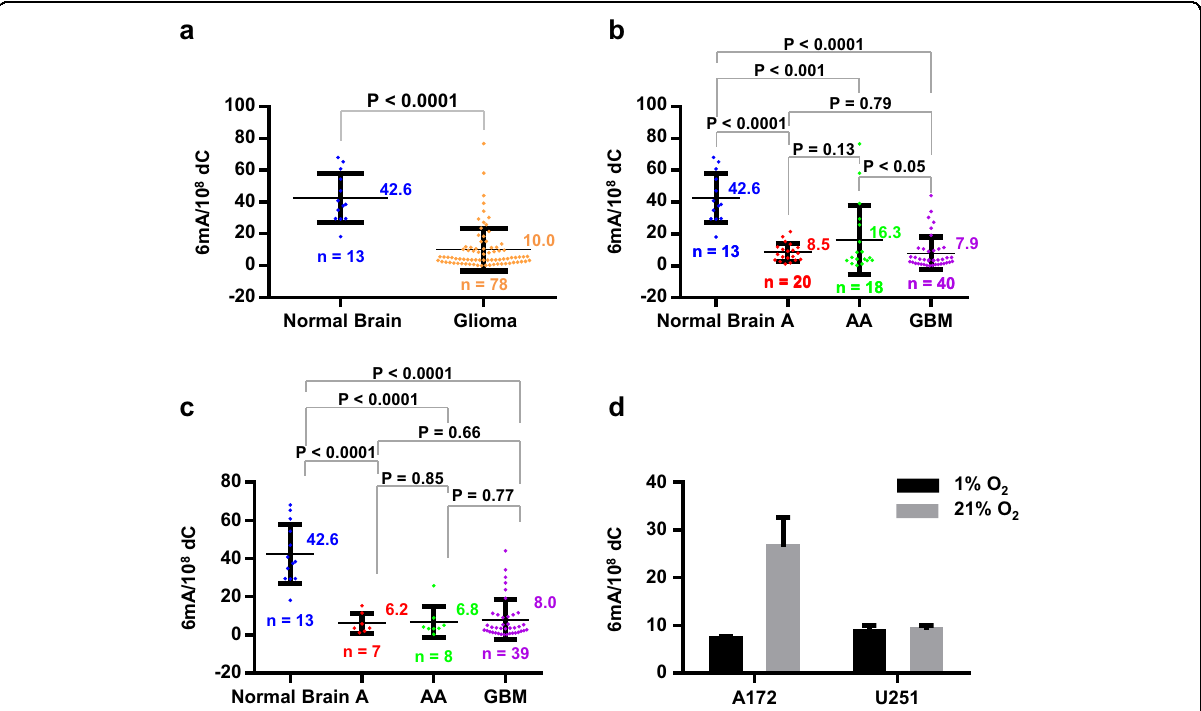
Fig. 3 Genomic DNA 6mA content at global level signi fi cantly decreases in hypoxic human gliomas. a DNA 6mA content in glioma tissues. Normal brain tissues: n = 13; glioma tissues: n = 78. b DNA 6mA contents in glioma tissues and normal brain tissues. Normal brain tissues: n = 13; Astrocytoma (A) tissues: n = 20; Anaplastic Astrocytoma (AA) tissues: n = 18; Glioblastoma (GBM) tissues: n = 40. c DNA 6mA content in glioma tissues with IDH1 mut being excluded. Normal brain tissues: n = 13; A tissues: n = 7; AA tissues, n = 8; GBM tissues: n = 39. d Hypoxia reduces misincorporated DNA in cultured human glioblastoma cells. Statistical signi fi cance was determined by Student ’ s unpaired t